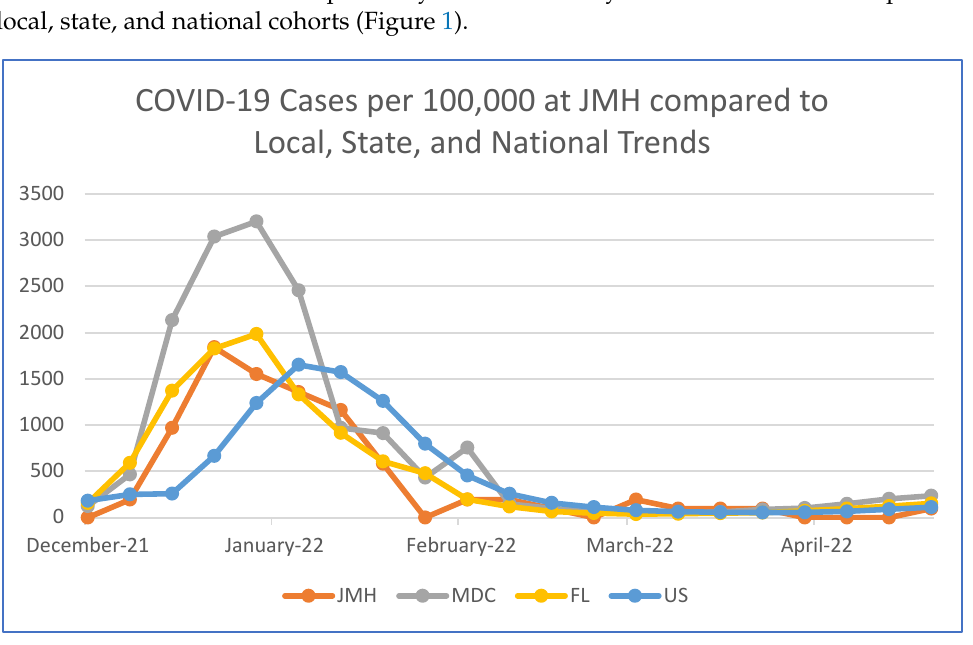
Figure 1. COVID-19 cases per 100,000 people in the JMH Hematology/Oncology clinic population compared to Miami-Dade County (MDC), the State of Florida (FL) [5], and the United States (US) [1]. 90 patients tested positive for COVID-19 (8.73% of total patients), while 6 providers